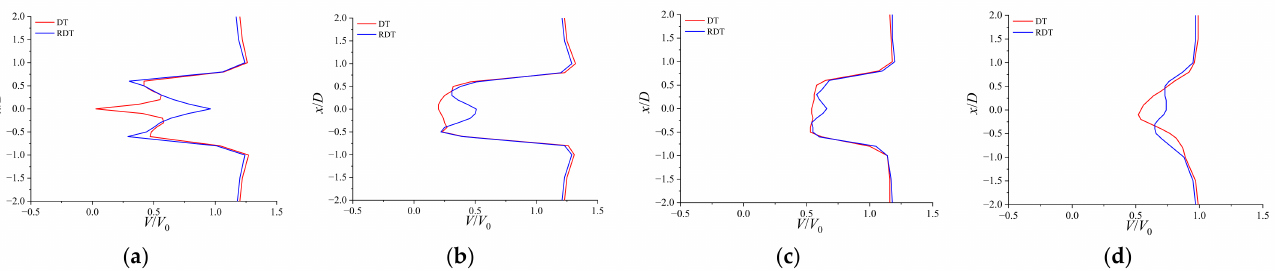
Figure 16. Profiles of mean streamwise velocity for TSR = 5.0 at different streamwise locations in the central x - z plane: ( a ) z / D = 0.5; ( b ) z / D = 1.0; ( c ) z / D = 3.0; ( d ) z / D =